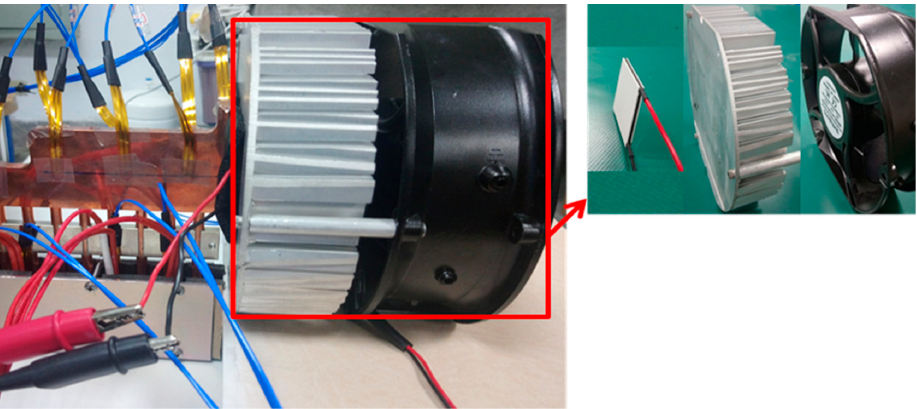
Figure 19. A heat dissipation system.